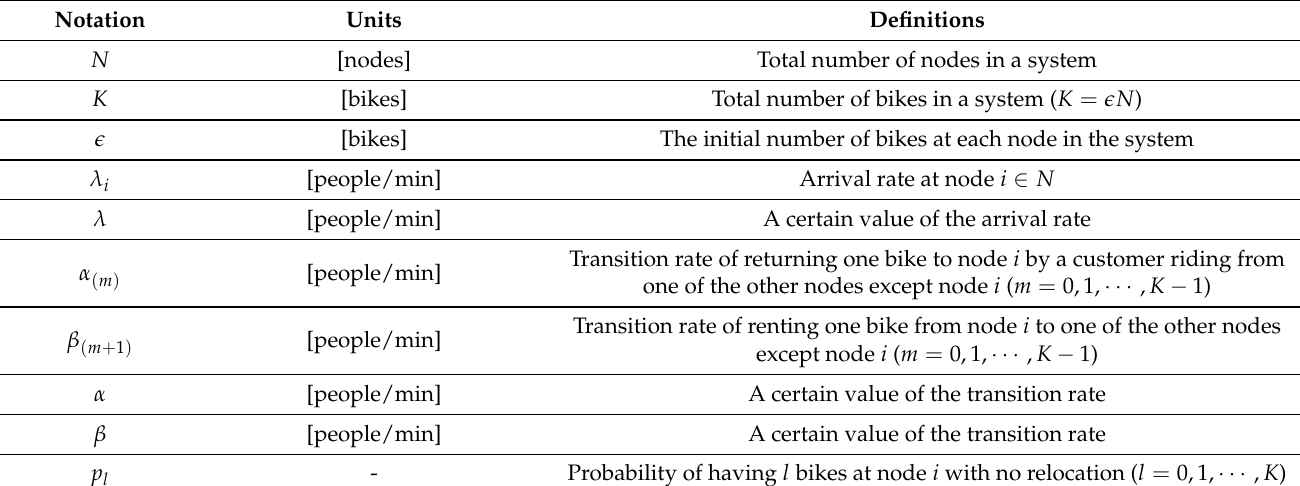
Table 1. Overview of